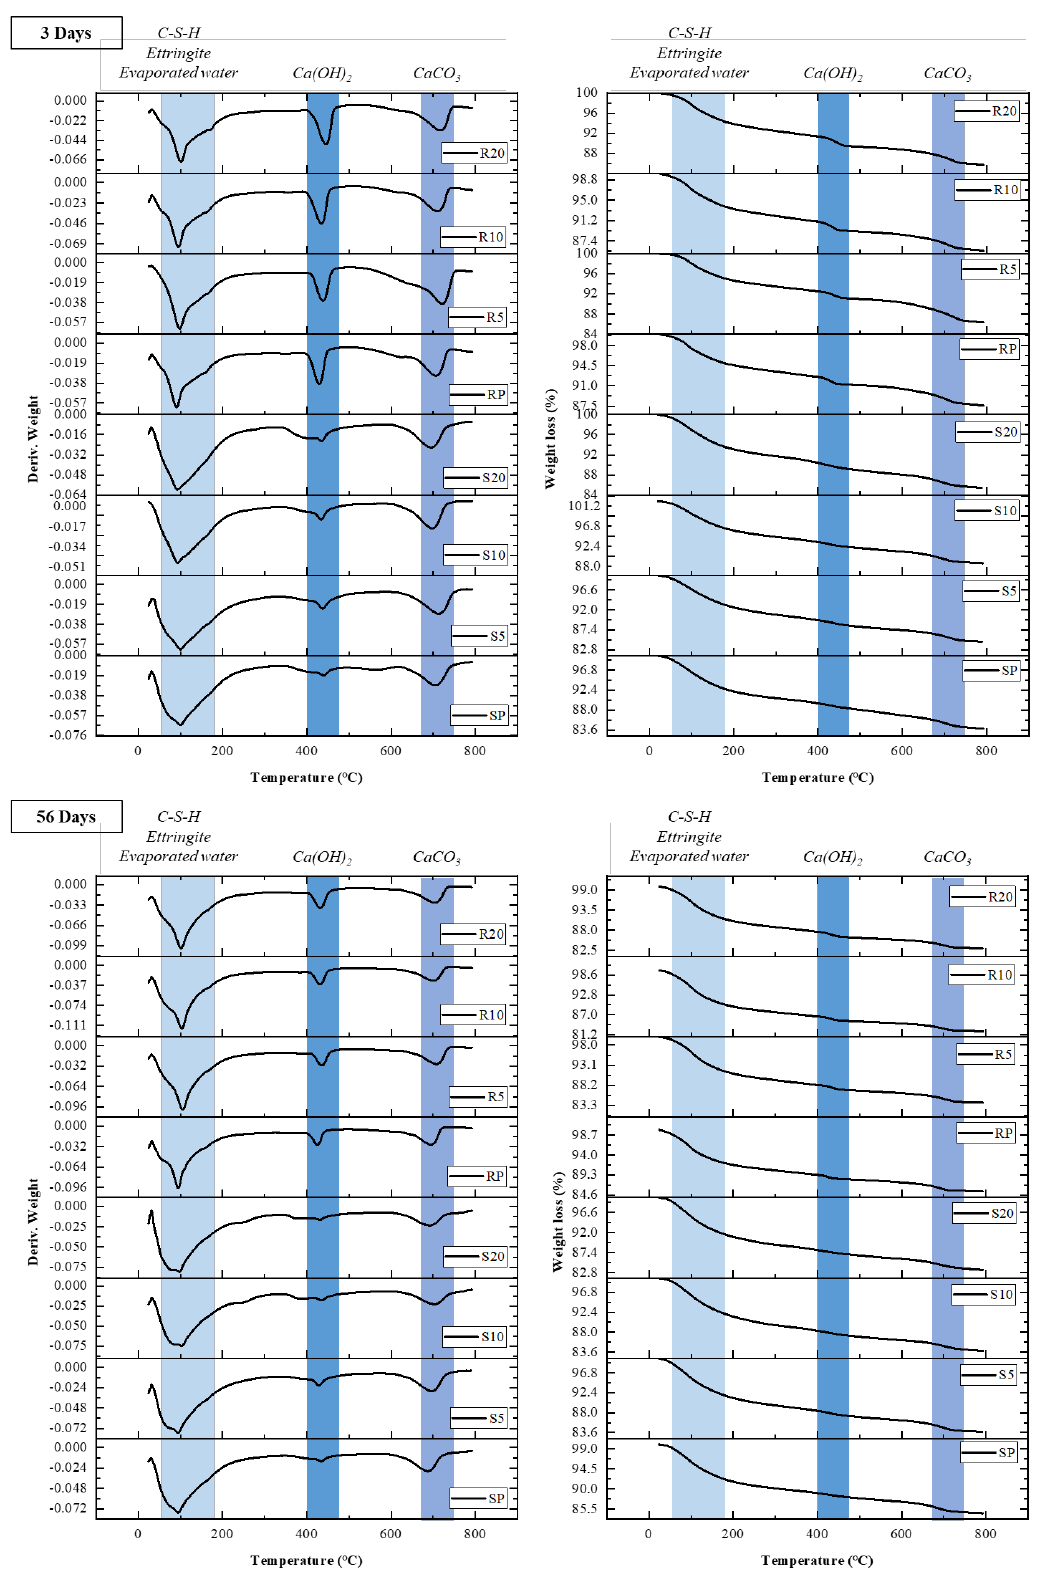
Figure 7. Thermogravimetric analysis (TGA) of samples at the ages of 3 and 56 d (the derivative TG (DTG) and weight reduction curves of the steam curing and room temperature curing specimens are classified according to age, and the combustion materials are selected according to the temperature range.).